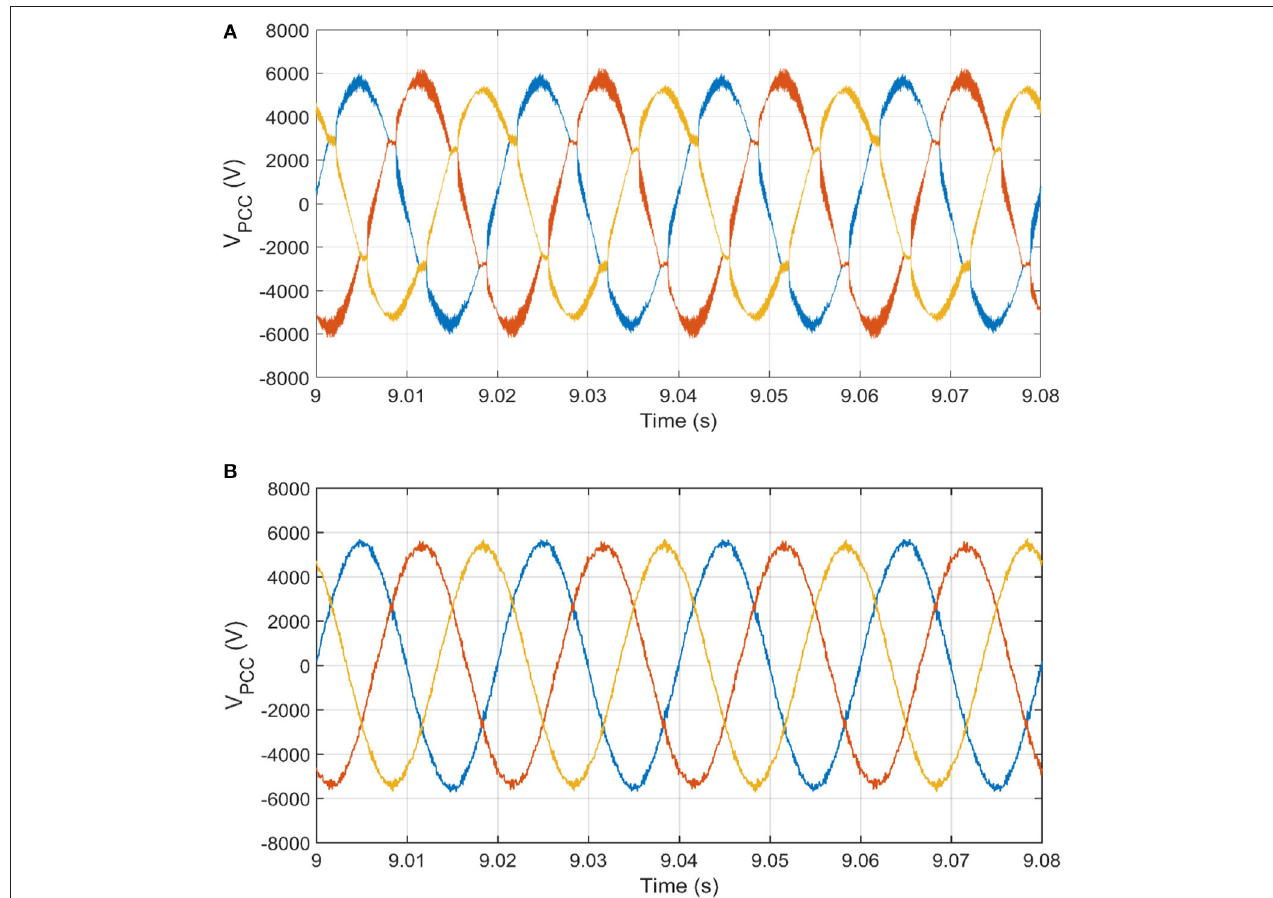
FIGURE 10 | Voltage waveforms at PCC before and after the activation of unbalance and harmonics control. (A) Voltage waveform at PCC distorted by harmonics and unbalance. (B) Voltage waveform at PCC with mitigation of harmonics and unbalance.